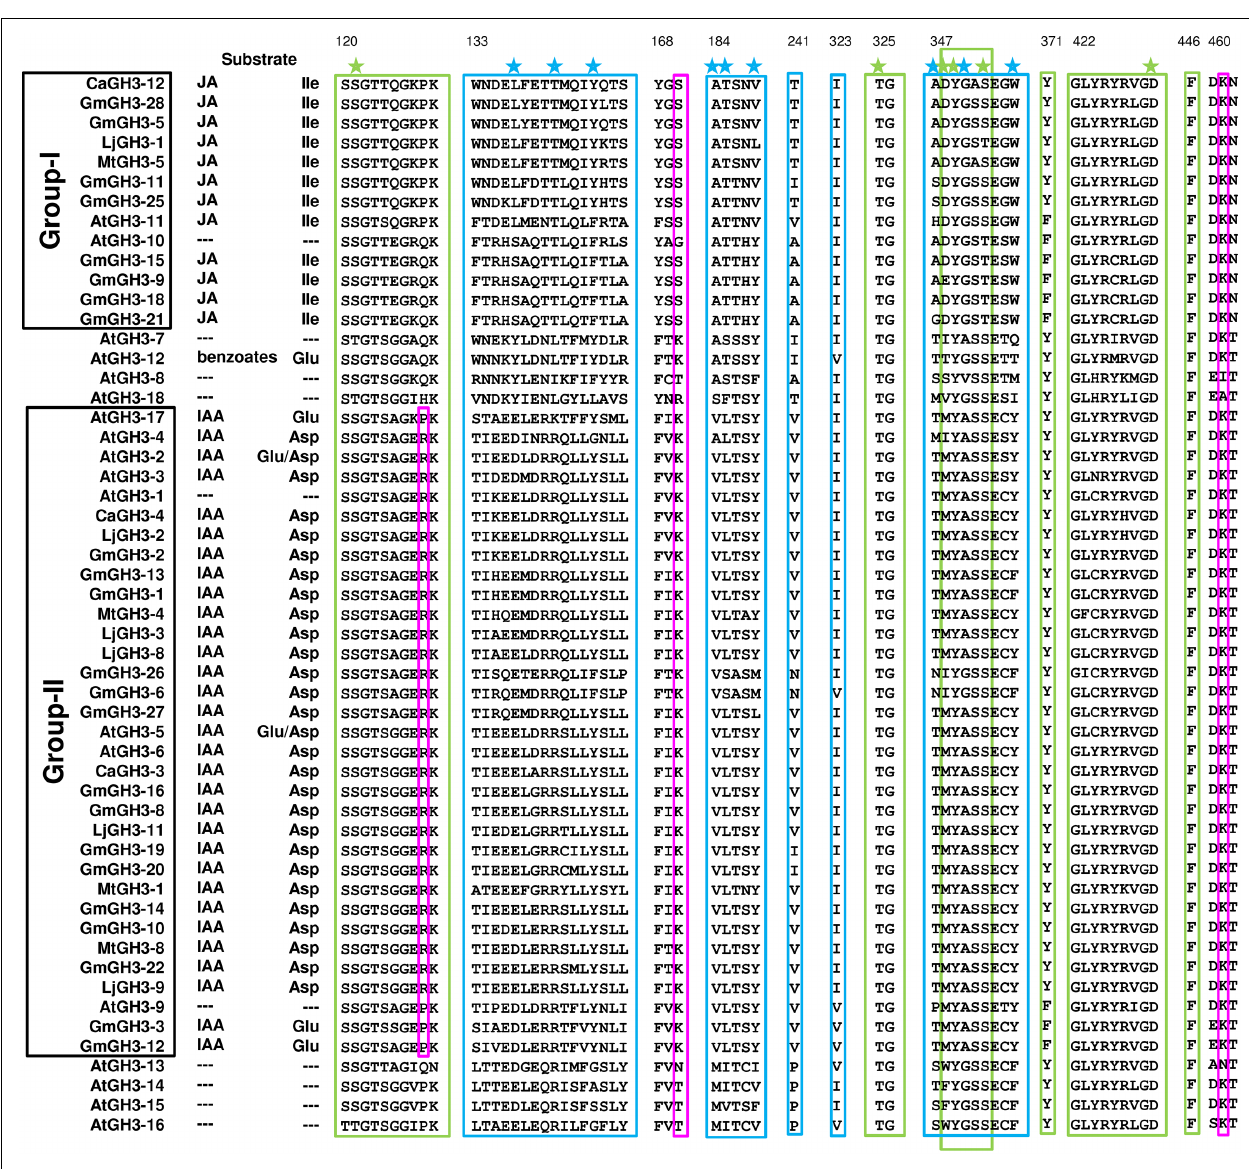
boxes represent residues determining amino-acid preferences. Only sequences with complete C - and N -terminal domains were included. Star across the top of the alignment indicates conserved residues in pocket forming active site. Numbering at the top corresponds to